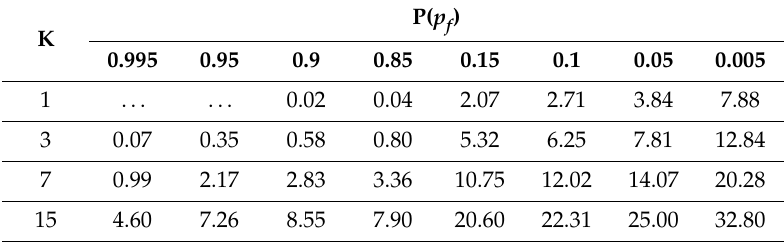
Table 2. Probability distribution table of chi-squared